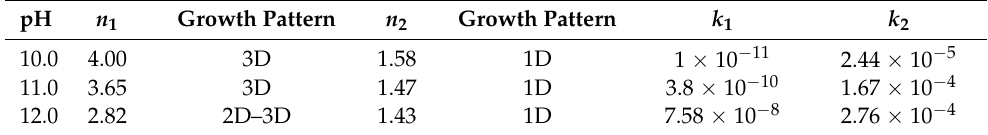
Table 2. Gelation kinetics parameters of PEG/PAMAM hydrogels (pH 10.0–12.0).